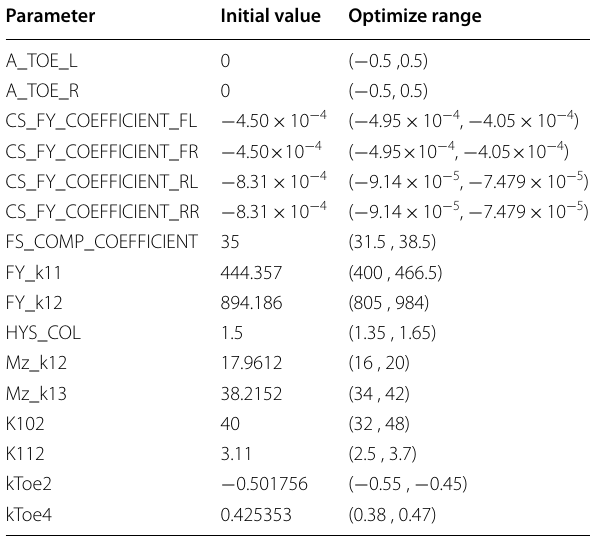
Table 3 Initial parameter values and optimization range